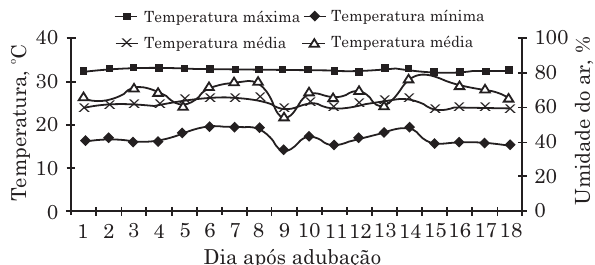
Figura 2. Temperatura e umidade relativa no interior da casa de vegetação referente ao período de avaliação das perdas por volatilização da